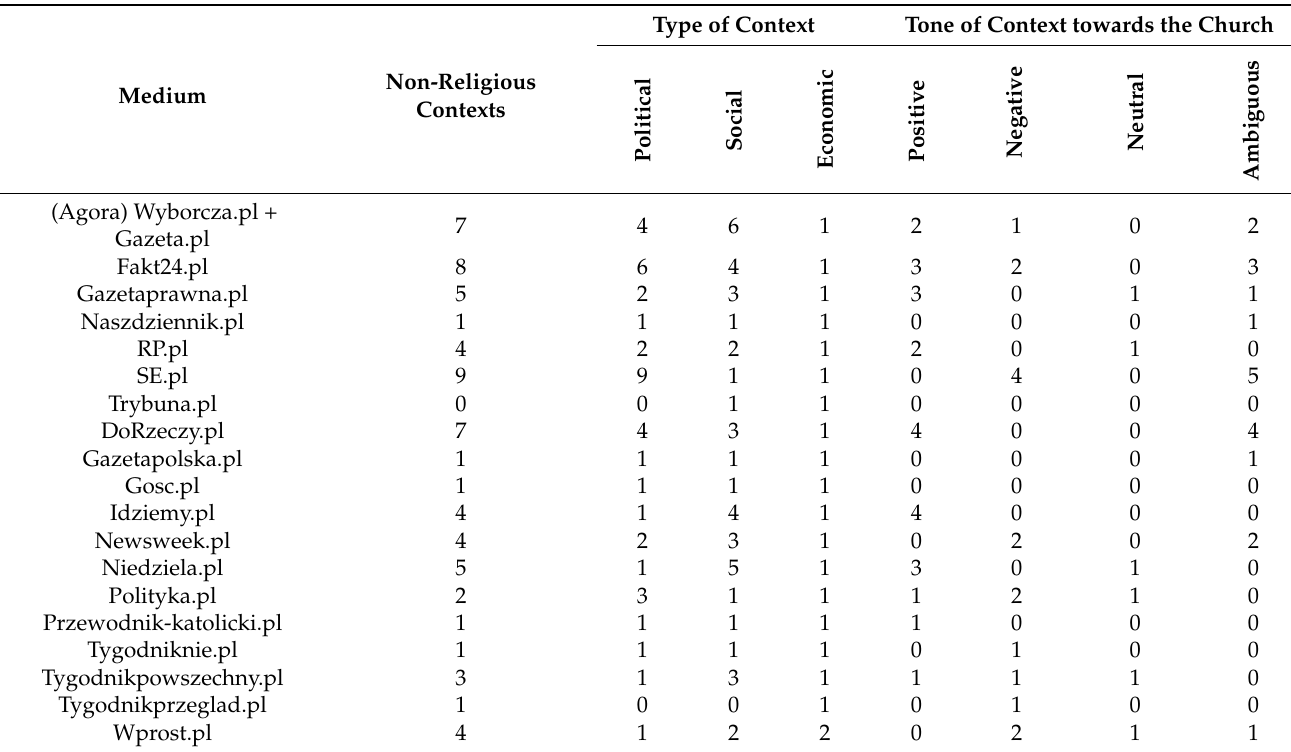
Table 4. Non-religious contexts—character (the numbers do not add up, as one text could have several contexts).